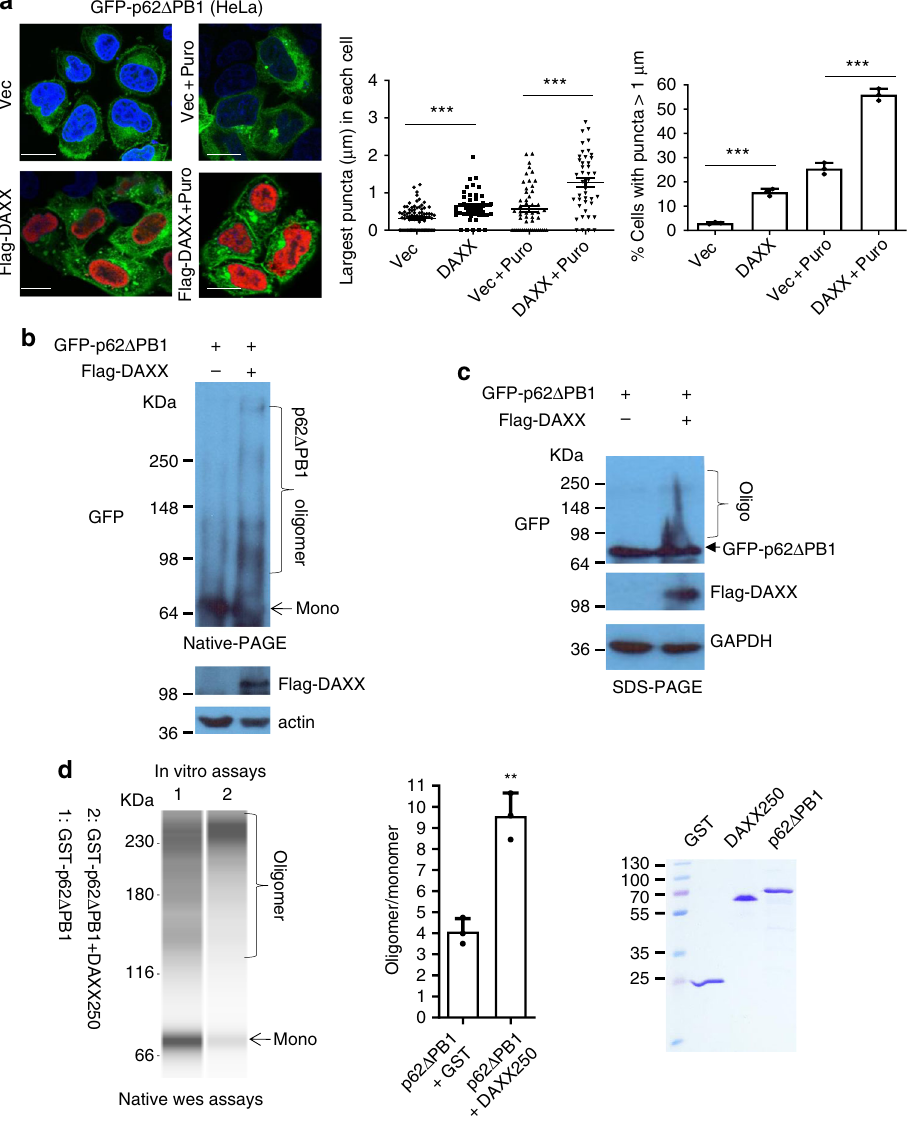
Fig. 6 DAXX promotes p62 oligomerisation independently of PB1 domain. a GFP-p62 with 1-120aa deletion (GFP-p62 Δ PB1) was co-transfected into HeLa cells with vector or Flag-DAXX. After 20 h, the cells were treated without or with puromycin for 5 h. The cells were fi xed, and stained with anti-Flag antibody. The images were acquired with a confocal microscope. Bar: 10 µ m. The diameter of the biggest GFP-p62 Δ PB1 puncta in each cell was measured (LAS). n = 88 (Vec), 49 (DAXX), 51 (Vec + Puro), 43 cells (DAXX + Puro) from three independently plated wells. The percentage of cells with GFP- p62 Δ PB1 puncta > 1 µ m was assessed. n = 3 independently plated samples for each group. Statistical analysis was performed with unpaired two-tailed T-tests. Data are shown as mean ± sem. *** P < 0.0001 (left); *** P = 0.0001 (right). b GFP-p62 Δ PB1 was co-transfected into HeLa cells with empty vector or Flag-DAXX. After 20 h, the cell lysates were subjected to native PAGE, and immunoblot with anti-GFP, or SDS-PAGE and immunoblot with anti-Flag and anti-actin. c GFP-p62 Δ PB1 was co-transfected into HeLa cells with empty vector or Flag-DAXX. After 20 h, the cell lysates were subjected to SDS-PAGE and immunoblot with anti-GFP, anti-Flag and anti-GAPDH. d Simple Wes assays. Bacterially expressed GST-p62 Δ PB1 (0.5 µ g) was incubated with GST or GST-DAXX 1-250aa (DAXX250) (1.5 µ g) in 1× PBS at room temperature. After 48 h, the mixtures were subjected to native Wes assays with anti-p62 (1:100) (see Methods for details). The ratios of oligomeric versus monomeric GST-p62 Δ PB1 were digitally recorded. n = 3 independent experiments. Statistical analysis was performed with unpaired two-tailed T-tests. Data are shown as mean ± sd. ** P = 0.0017. The recombinant proteins were subjected to